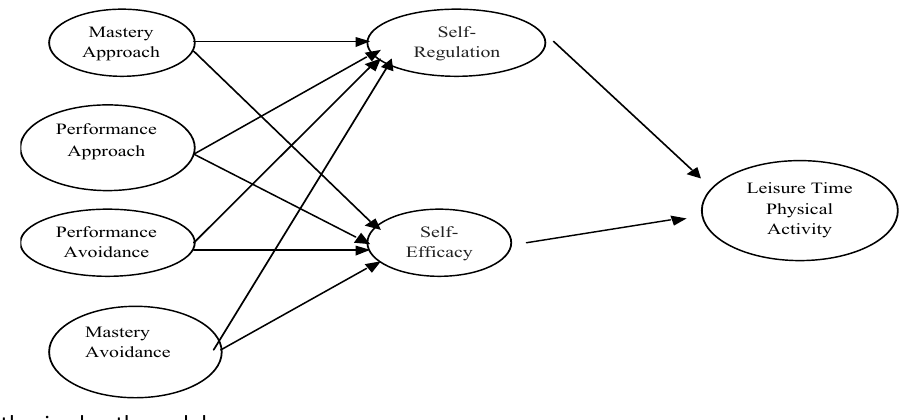
Figure 1 . Hypothesized path Table 1. Distribution of participants by gender and grade level Grade Level